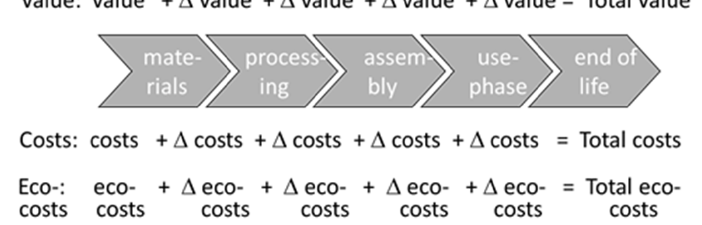
Figure 4. The basic idea of the Eco-costs/Value Ratio (EVR): combining the value chain with the ecological chain [33].